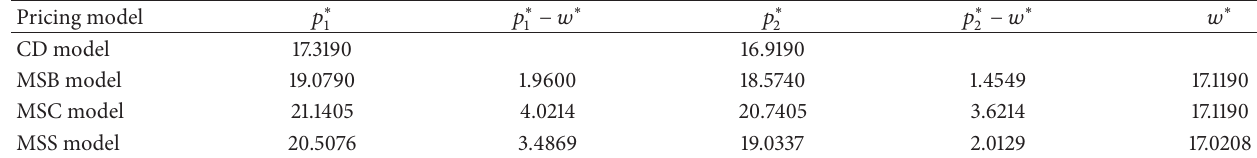
Table 2: Optimal retail prices and wholesale price under different pricing models. Pricing